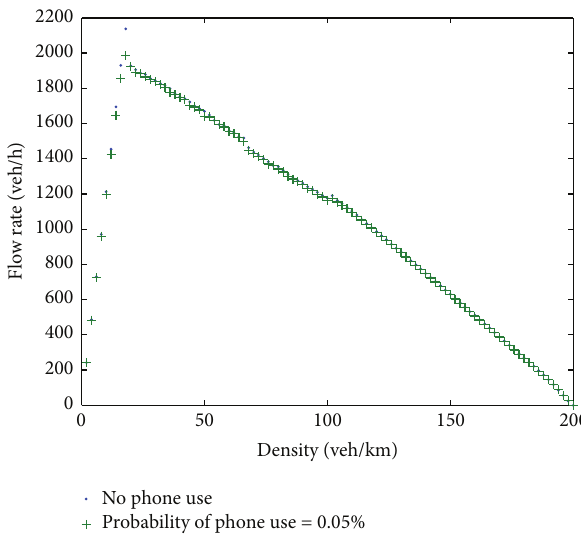
Figure 2: The fundamental diagram of driving with phone use.